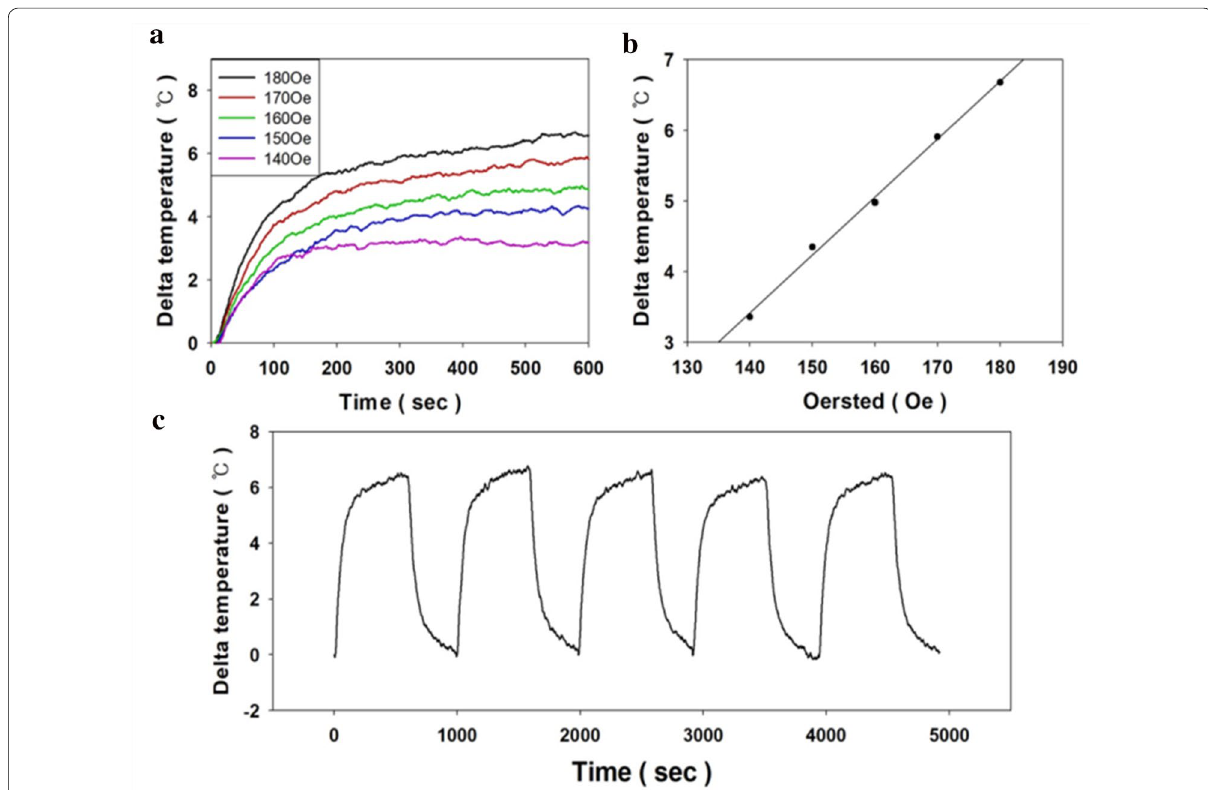
Fig. 6 Magnetic hyperthermia characteristics of the synthesized nanoparticles (10 mg/ml) ( a ), according to the strength of external magnetic field ( b ) maximum temperature versus various oersted and their fitting curve (linear reference line) ( c ) cycle